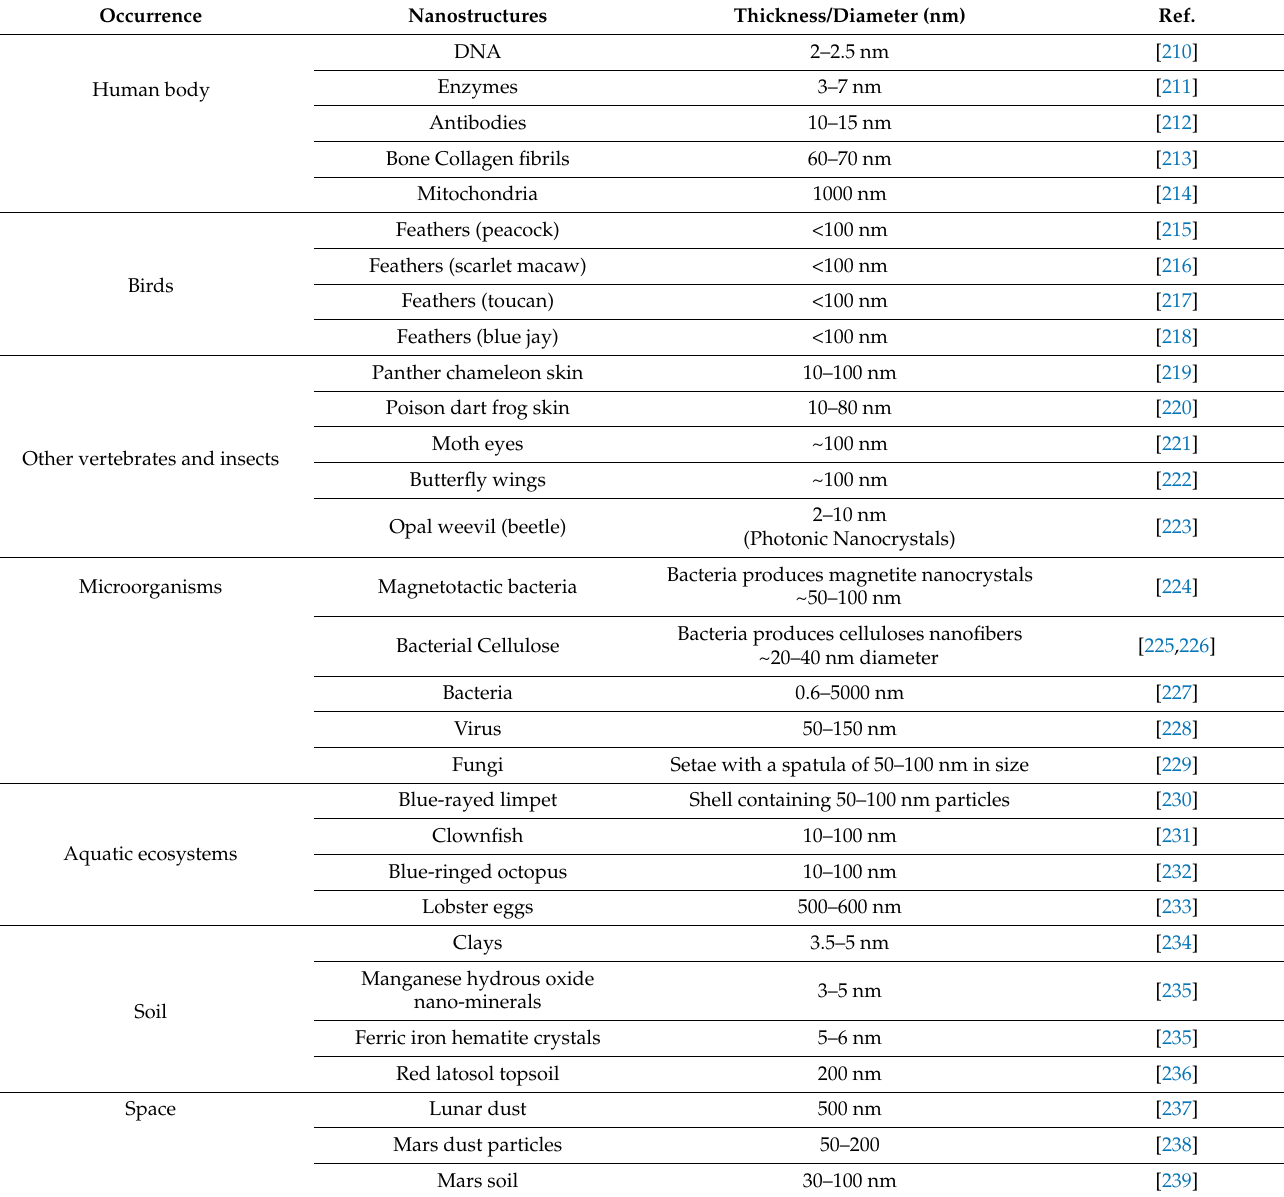
Table 4. Natural nanomaterials in living organisms and